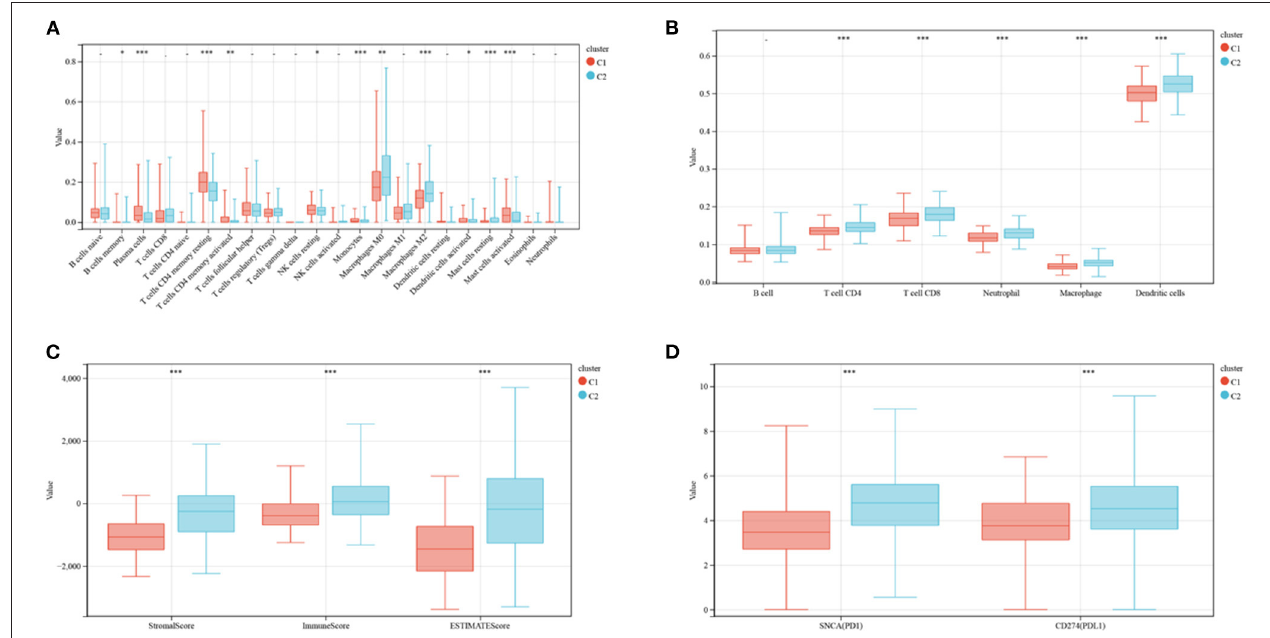
FIGURE 3 | Evaluation of immune infiltration and checkpoints in the two subtypes. (A) CIBERSORT analysis of the abundance of 22 immune cells infiltrating tumors of the two subtypes. (B) TIMER analysis of the abundance of six immune cells infiltrating tumors of the two subtypes. (C) Stromal, immune and ESTIMATE scores of patients in the two subtypes. (D) Expression of immune checkpoints by tumors in the two subtypes.